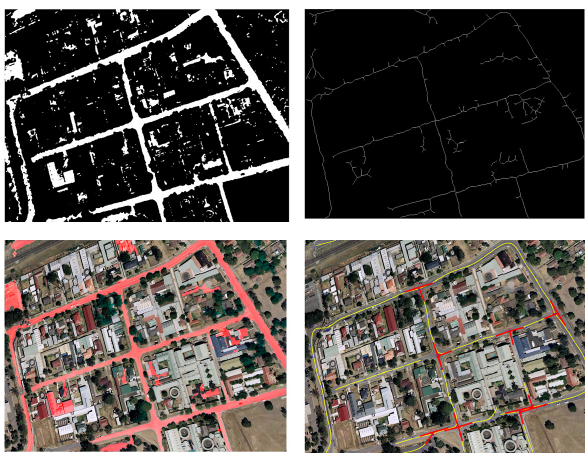
Figure 8: Road extraction example stages: (a) raw road segmen- tation, (b) road components superimposed on the original image, (c) road skeleton, (d) road network with road centrelines shown in yellow and intersections in red.